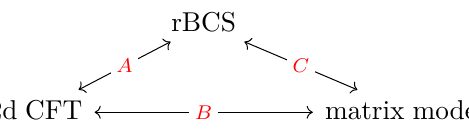
Figure 1 . The arrow A indicates the BCS/CFT correspondence [65], in which eigenfunctions and eigenvalues of the Hamiltonian (1.7) are obtained in the saddle point limit from deformed WZW conformal block in the Coulomb gas representation. The arrow B represents known formal agreement between the Dotsenko-Fateev [76, 77] (Coulomb gas) integrals and Penner-type random matrix integrals [78]. The arrow C stands for a link between random matrices and integrable systems that can be named the Bethe/matrix models duality. It manifests itself in that, that for an appropriate choice of the potential, saddle point equations for the matrix model integral, i.e., equations for critical points of the matrix model action, are formally identical to the Bethe ansatz equations for some quantum integrable models. In particular, for certain Penner logarithmic potentials stationary points equations are identical to the Bethe ansatz equations of the reduced BCS model, see e.g. [79].